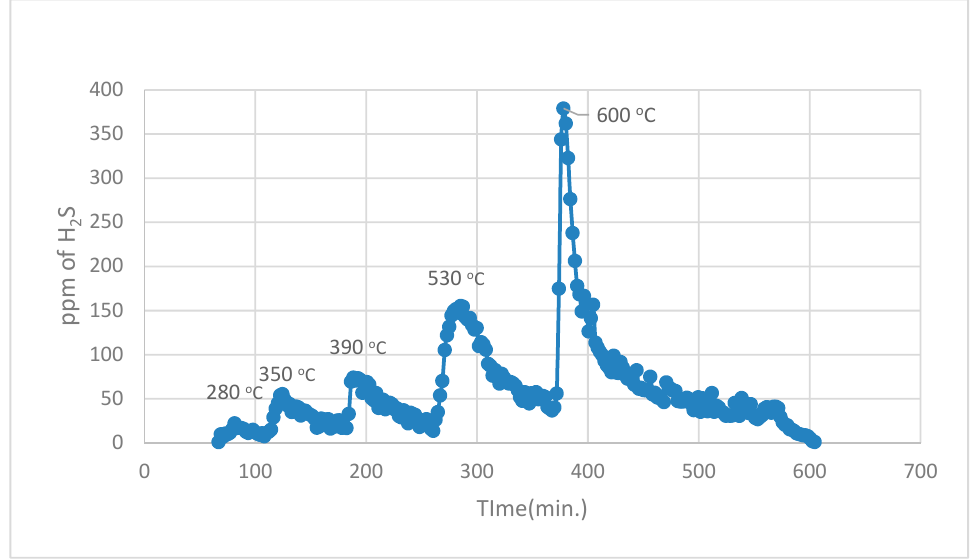
Figure 1. TPR of untreated ollerton coal.